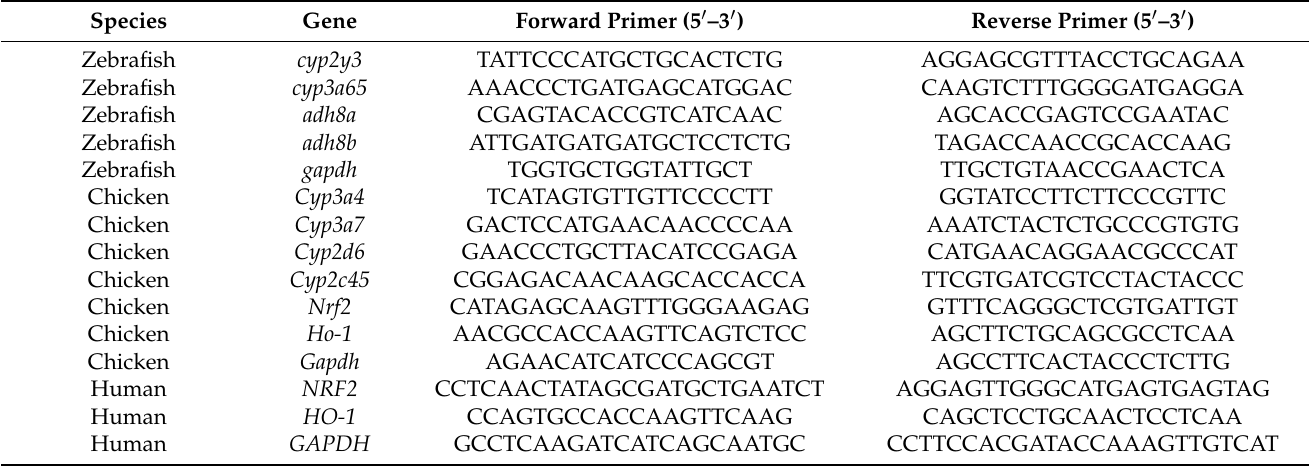
Table 1. Sequences of primers used for qRT-PCR [12,13,15,16]. Species